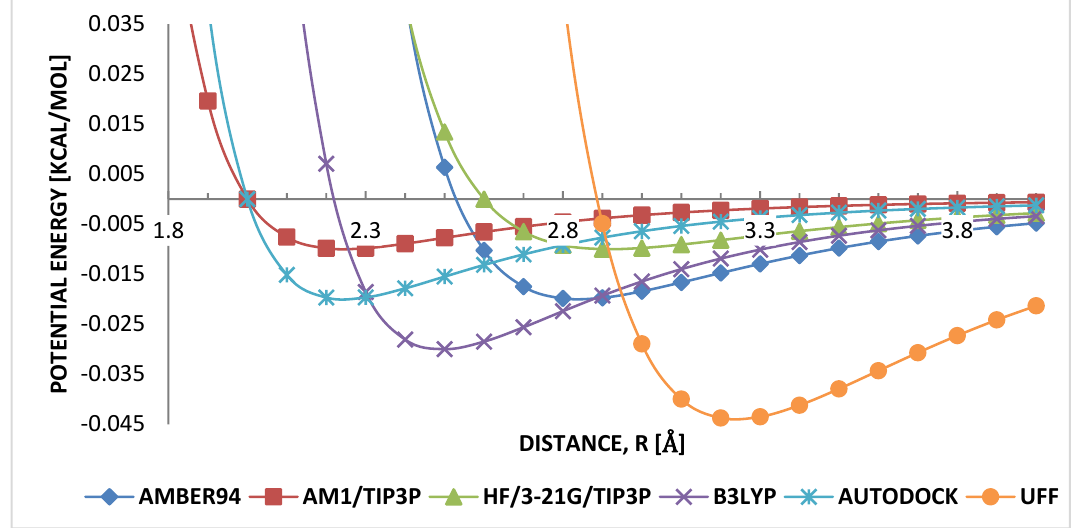
Figure 6. Comparison of LJ parameters hydrogen–hydrogen.